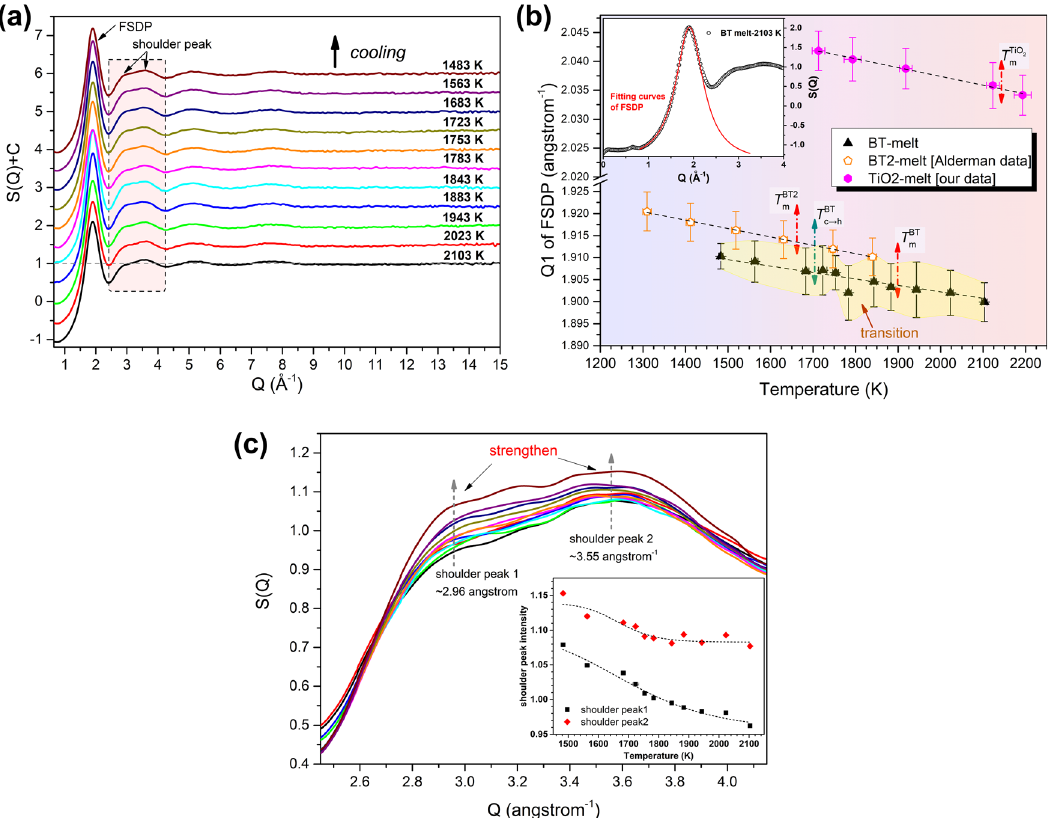
Fig. 3 Reciprocal-space structural evolution of the BT melt during cooling. a Faber – Ziman structure factors, S ( Q ), of molten BT at different temperatures. Note: FSDP represents the fi rst sharp diffraction peak. b Variation of the FSDP position as a function of temperature of the BT melt. Data for molten TiO 2 and BaTi 2 O 5 melt 47 are included for comparison. The inset fi gure is the Lorentzian fi tting for FSDP of S ( Q ) at 2103 K. Peak position and its associated error bar of FSDP were extracted by the following strategy: the peak position at its maximum intensity is read directly and denoted as Q 1 ʹ , and that obtained by Lorentzian fi tting is denoted as Q 1 ʺ . Q 1 and its uncertainty are de fi ned as | Q 1 ʹ + Q 1 ʺ |/2 and | Q 1 ʹ − Q 1 ʺ |/2, respectively. c An enlarged view of the second peak in the S ( Q ) patterns marked by the dashed rectangle. The inset fi gure shows the variation of the intensity of two shoulder peaks with